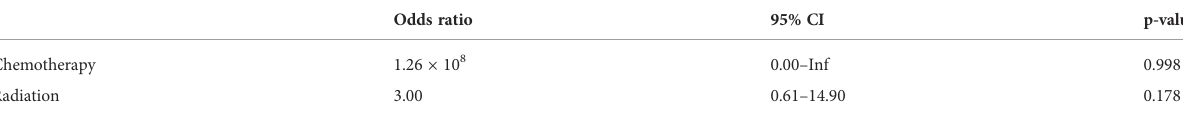
TABLE 7 Comparison of patients with recurrent and nonrecurrent cancer following cancer treatment (matched-pair logistic regression analysis with BMI matched by caliper of 0.2 standard deviations). Odds ratio Chemotherapy